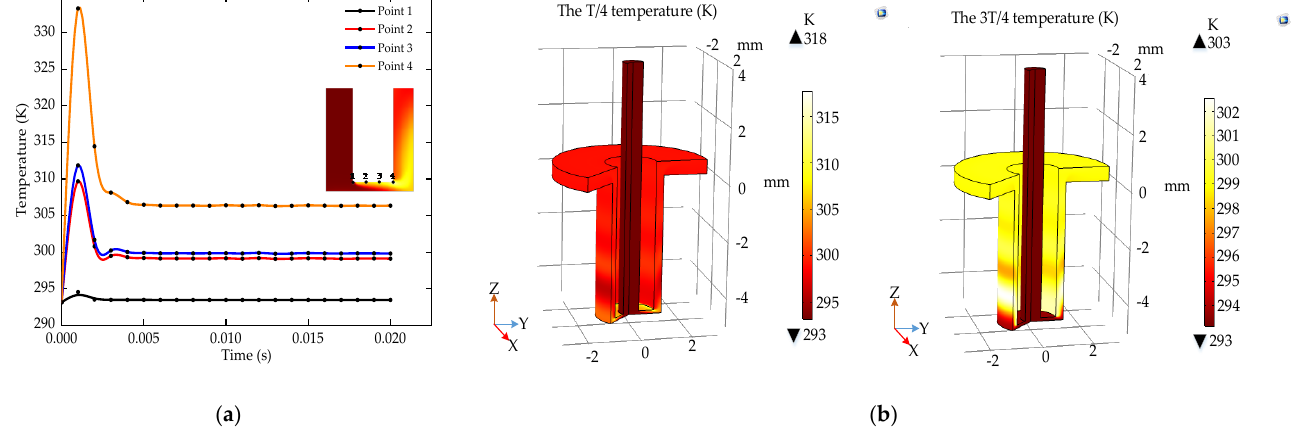
Figure 5. The temperature distribution of the pulse ECM; ( a ) the temperature change rules of reference points; ( b ) the temperature during a pulse period.